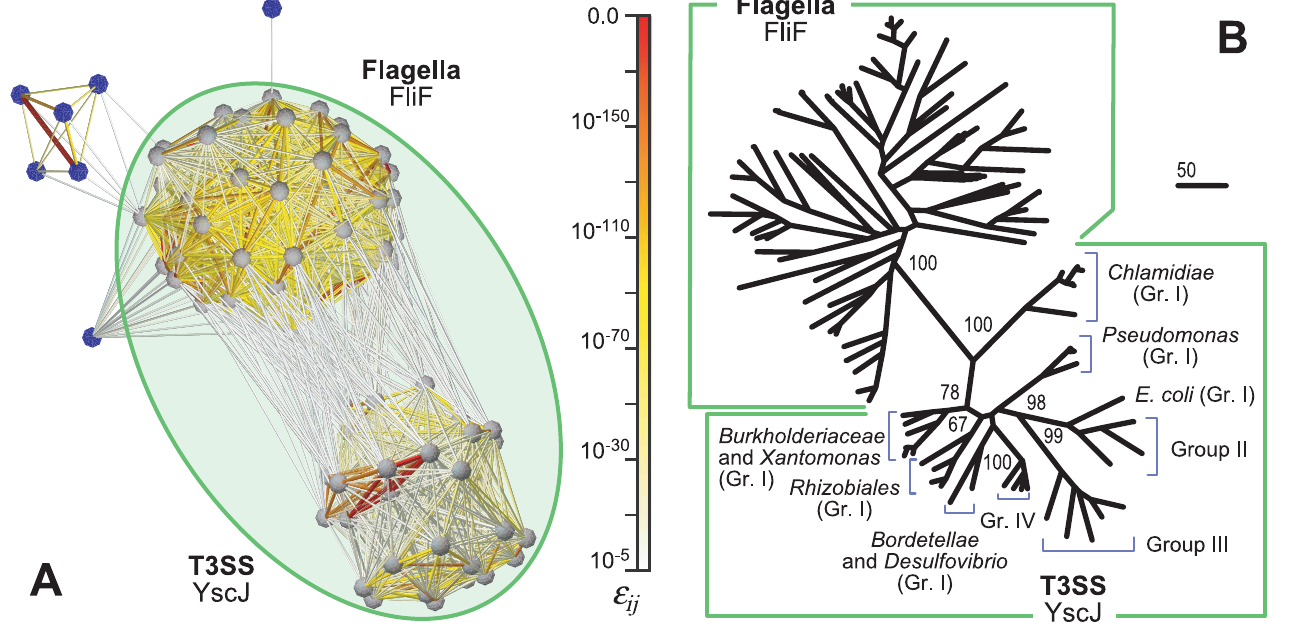
Figure 6. SctJ PHN-Family: Network and Phylogeny